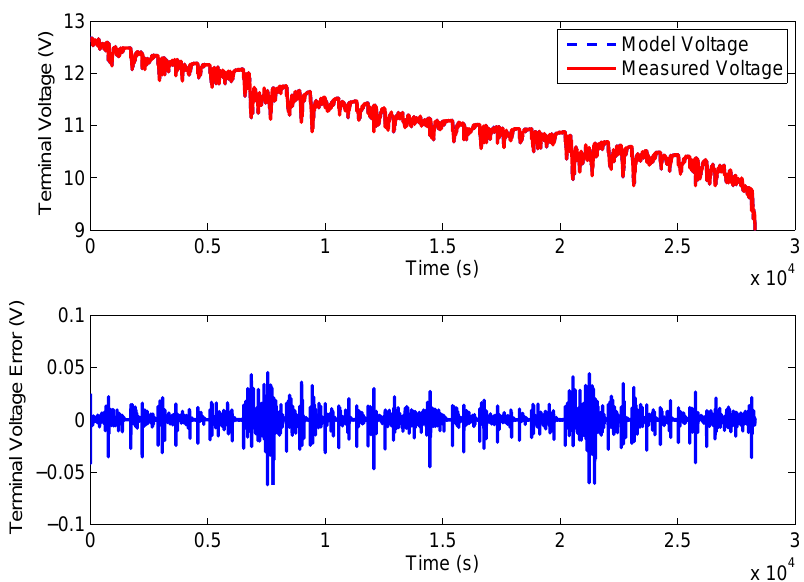
Figure 12. Experimental terminal voltage results using VB-ADEKF in the UDDS test.